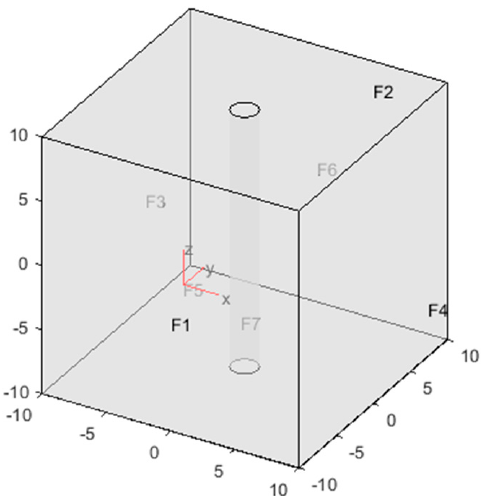
Figure 13. Following Figure 5, a wellbore-centric data cube of 161 nodes with node spacing ~12 cm and a 3 m radius wellbore denoted by shaded vertical shaft with interior surface face F5. External boundary faces are F1–F4 and F6–F7. Pressure, temperature, and/or flux boundary conditions at faces F1–F7 define the steady-state flow/advection simulation performed by Matlab finite-element solvers (6) and (7). The effect of the large wellbore radius is to reduce the model area over which to axially conduct heat away from the model radial inflow structure.